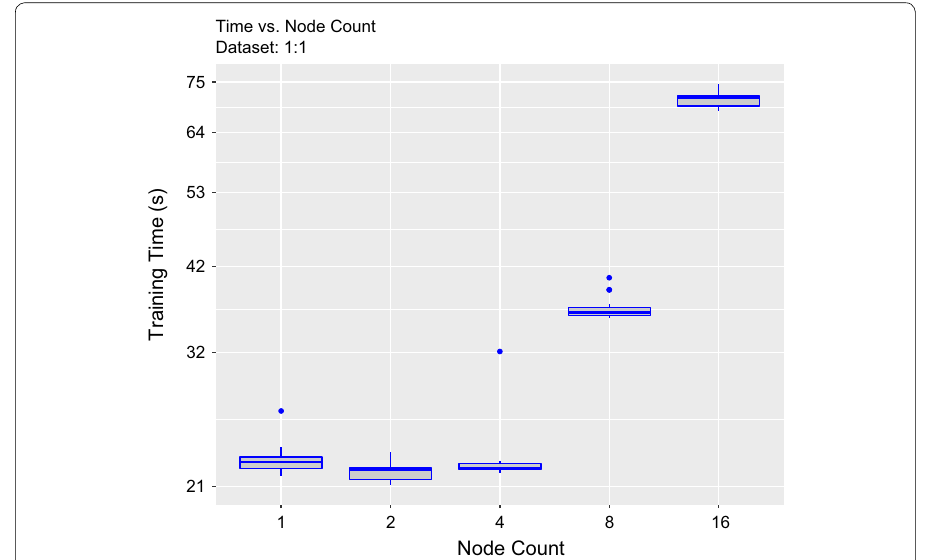
Table 1 ANOVA Table showing the number of nodes in a cluster is a statistically significant factor regarding training time training time on the 1:1 dataset size Df Sum Sq